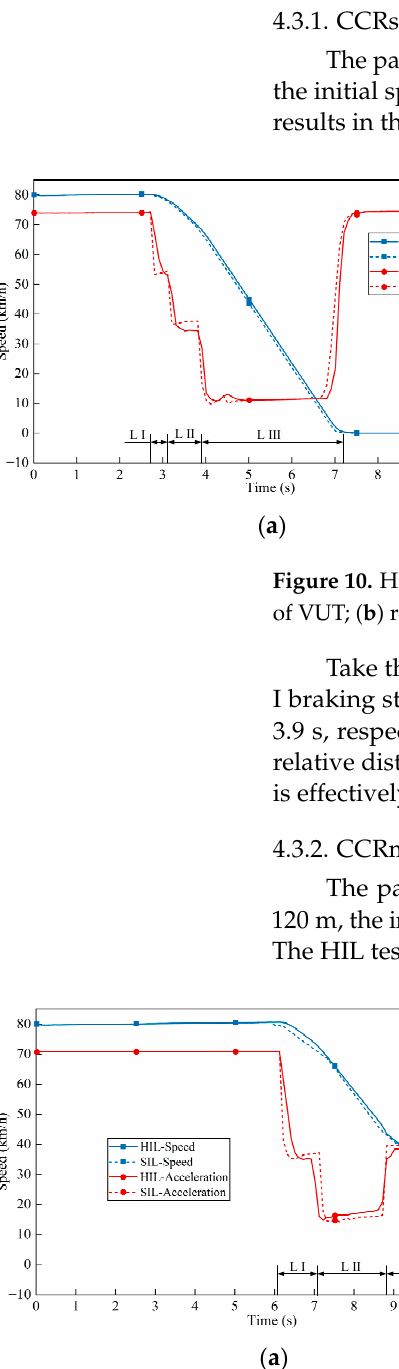
( b ) Figure 12. HIL testing and SIL testing results of CCRb condition: ( a ) speed of VUT and acceleration of VUT; ( b ) relative speed and relative distance. Take the HIL testing curve in Figure 12 as an example, the relative speed reaches 24 km/h at 2.3 s, and the VUT starts braking. Then, the TTC value rapidly decreases to below 2.25 s, and the VUT directly enters the L Ⅱ AEB braking status. As the VT continues to decelerate, the collision risk continues to increase, and the VUT enters the L Ⅲ AEB brak- ing status at 3.4 s. At the end of the braking at 7.4 s, the speed of VUT and the speed of VT both decrease to 0. During the braking process, the minimum relative distance is 5.11 m, and there is no collision between the VUT and the VT. 5. Discussion Based on the proposed verification system, an AEB hierarchical control algorithm was tested. Under the test conditions of CCRs, CCRm, and CCRb, the AEB hierarchical control algorithm can keep the relative distance between the VUT and the VT within a